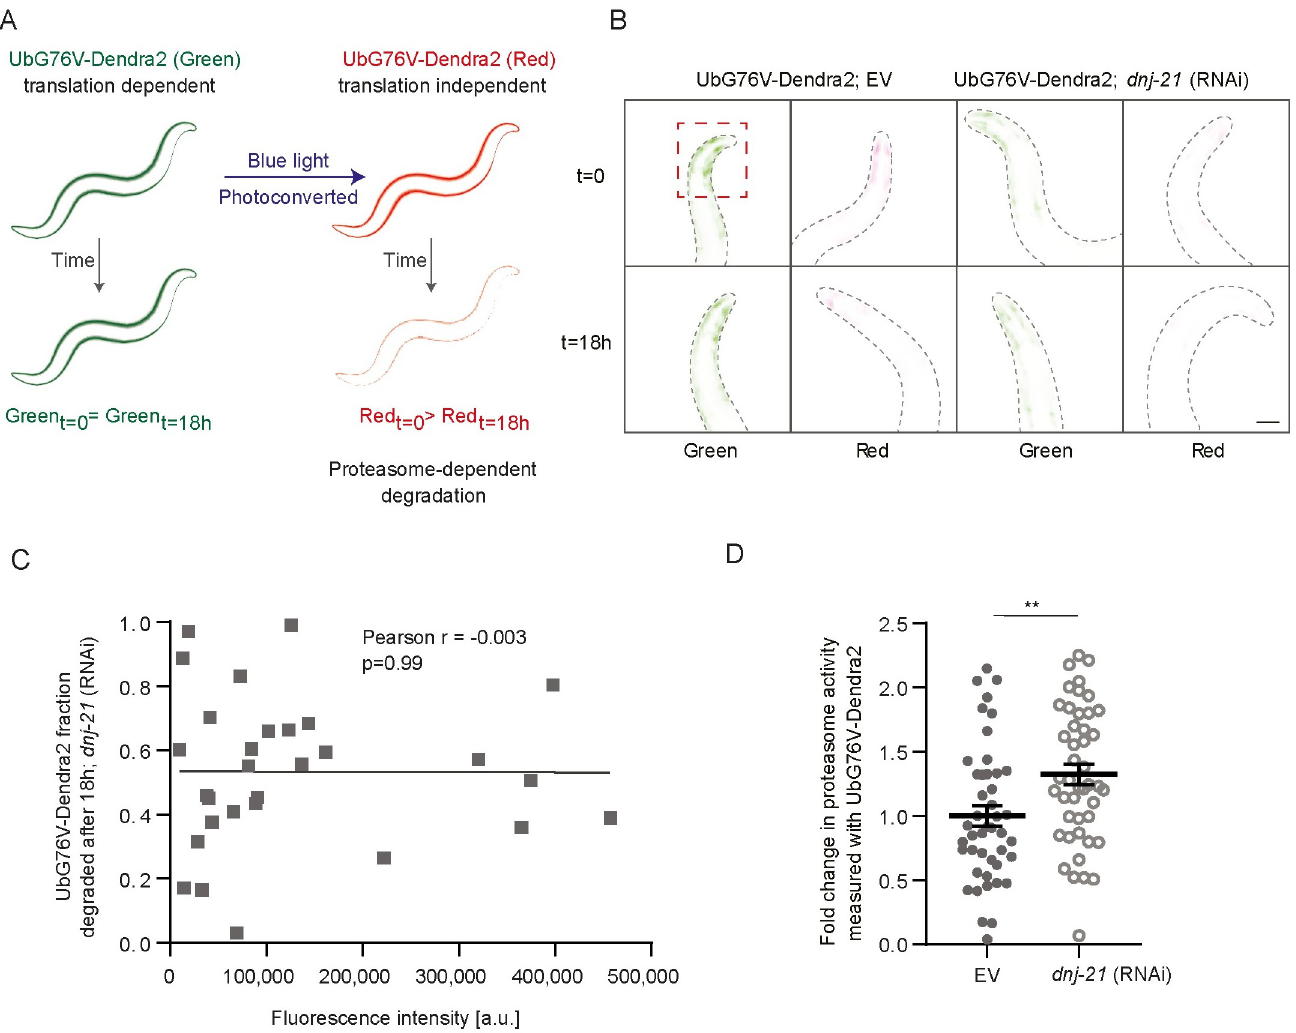
Fig 4. Mild mitochondrial stress regulates proteasomal activity. (A) Schema for measuring proteasomal activity using UbG76V-Dendra2 worms. Worms that expressed the photoconvertible GFP variant were exposed to blue light, thereby generating a red fluorescent variant. The time-dependent loss of red fluorescence reflects the speed of degradation by the proteasome. (B) Synchronized worms that expressed UbG76V-Dendra2 under the muscle-specific promoter ( unc-54 p) were exposed to RNAi until young adulthood. Green Dendra2 fluorescent protein was photoconverted, and the intensity of the red florescent variant was measured immediately and 18 h later. Representative images of 3 independent biological replicates are shown. Scale bar = 20 μ m. (C) Proteasome activity (shown as UbG76V-Dendra2 fraction that degraded after 18 h upon dnj-21 RNAi) does not correlate with expression of the reporter (shown as its fluorescence intensity). The gray line is the linear regression line, and each gray point represents one worm. n = 29. (D) Quantification of proteasomal activity upon DNJ-21 depletion. Shown are the ratios of t = 18 h/t = 0 that were normalized to the EV control. Data are presented as mean ± SEM; �� p < 0.01, n = 45, where n indicates the number of worms; 3 biological replicates were measured for each condition. Underlying numerical data are presented in S1 Data. EV, empty vector; GFP, green fluorescent protein; RNAi, RNA